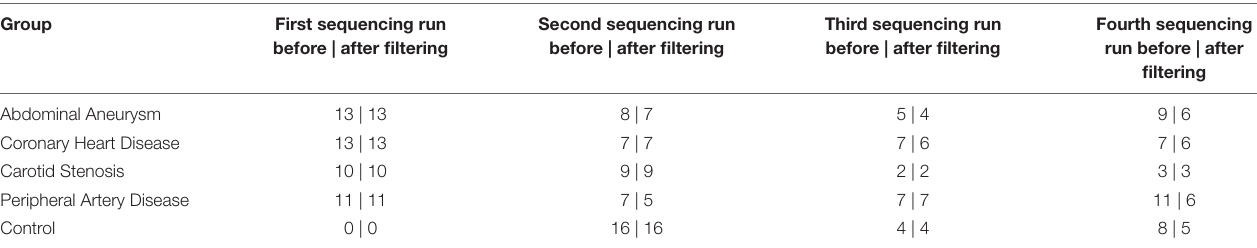
TABLE 4 | Summary of sequenced and analysed samples per sequencing